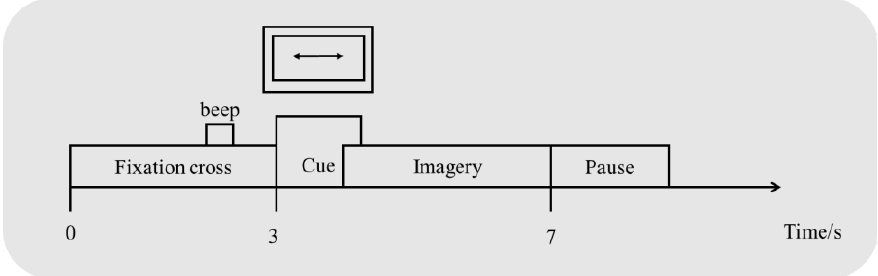
Figure 2. Schematic diagram of the experiment and the timing during a session using the BCI Competition IV dataset 2b.